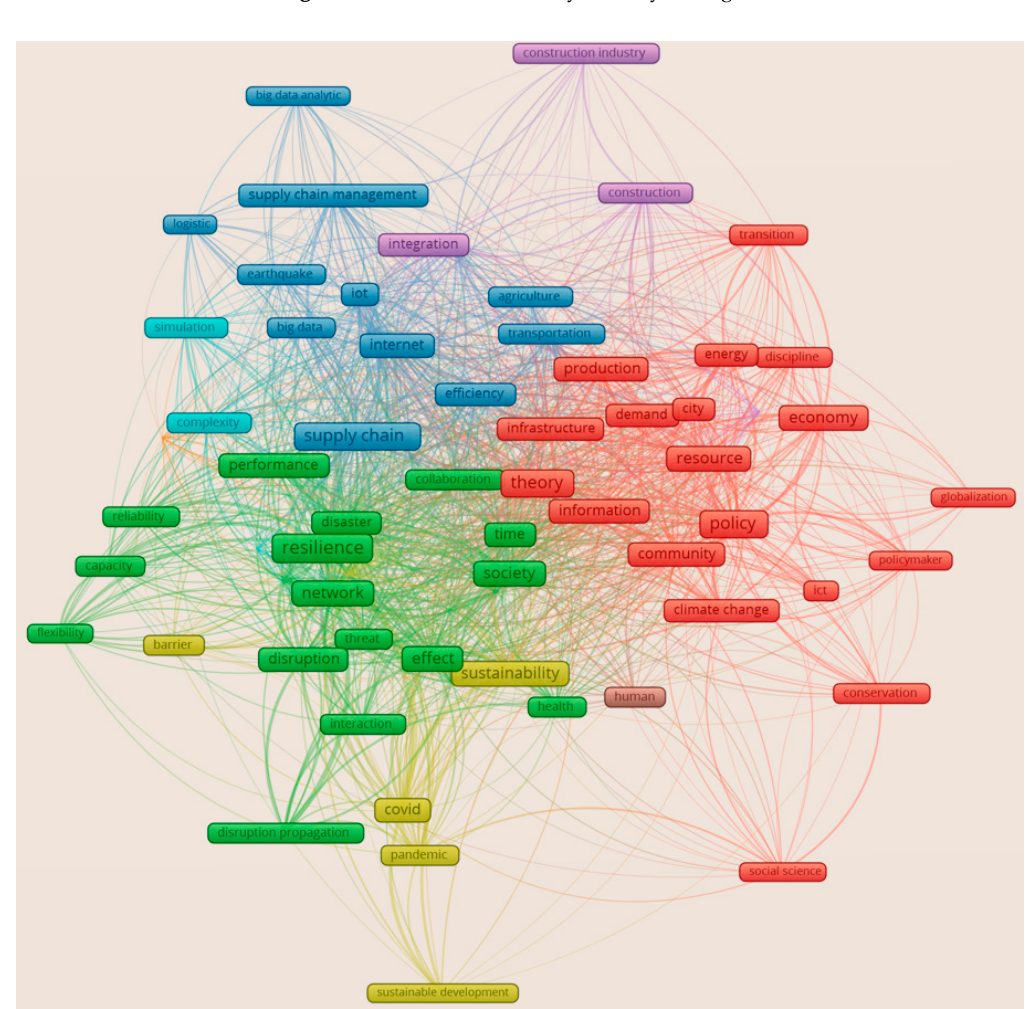
Figure 7. Co-occurrence analytical map of keywords established by bibliographic analysis of the 144 retrieved articles.